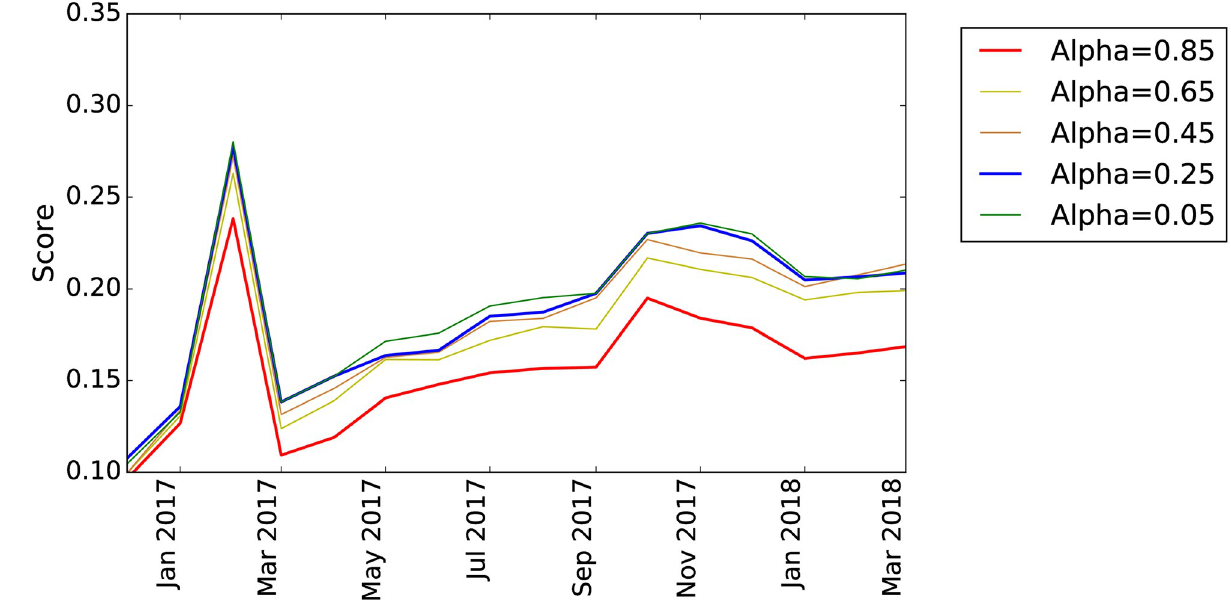
Fig 8. Recall@5% for the network model using a single step model with the PPR as unique feature for different values of α .